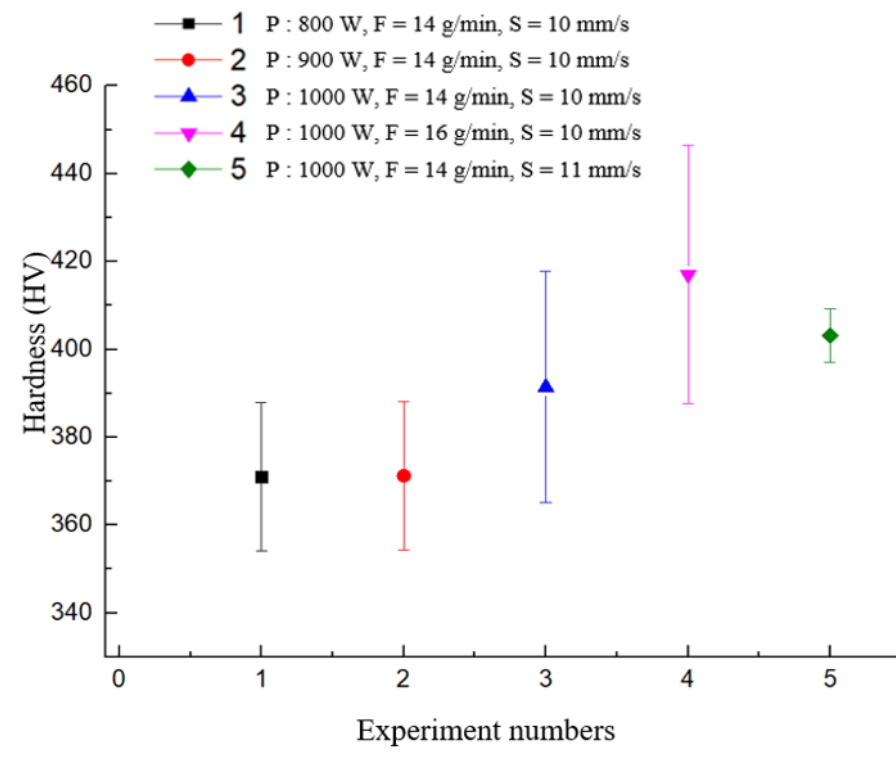
Figure 6. Hardness of deposited specimens according to condition. P: Laser power, F: powder feed rate, S: Scan speed.